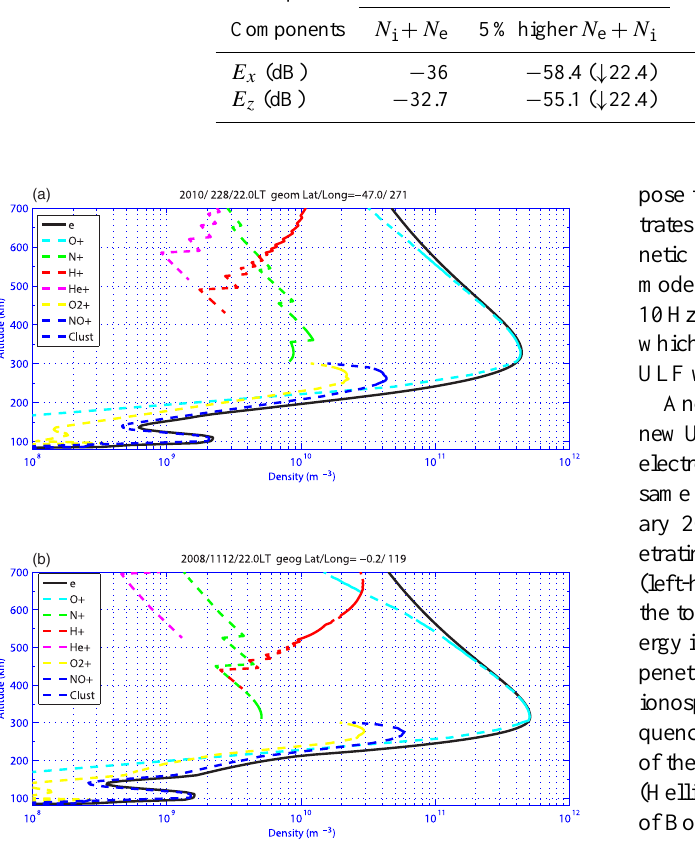
Figure 3. Ion and Electron densities profiles on 28 Febru- ary 2010 (a) and 12 November 2008 (b) at local time 22:00 be- fore two earthquakes (their geographical latitude and longitude are written on the top of each